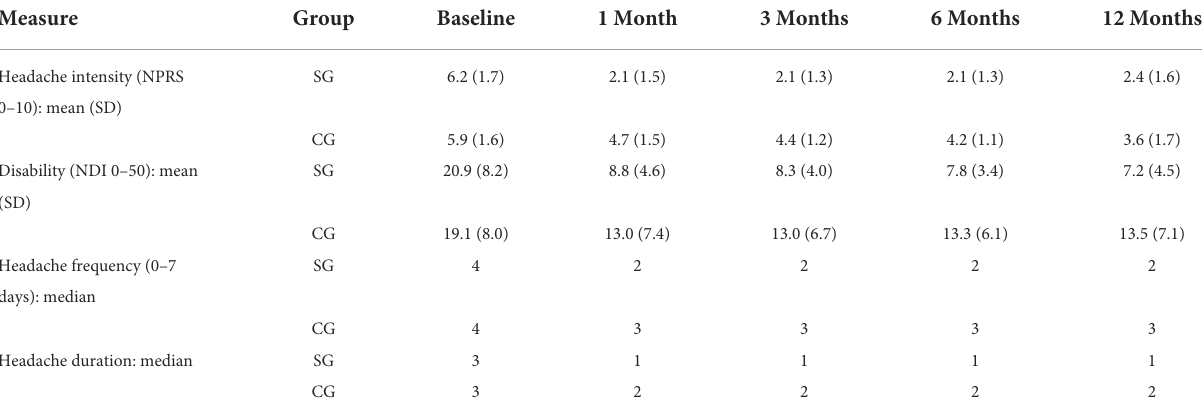
TABLE 4 All outcome measures over 12 months for each treatment